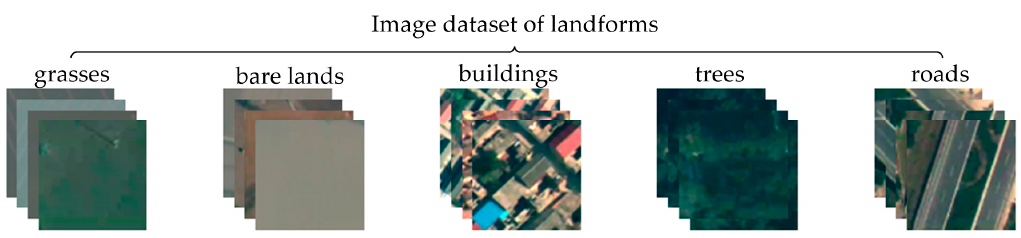
Figure 6. Image dataset of scenes. The designated categories are urban, suburban, rural, wilderness, and green land. Sensors 2018 , 18 , 156